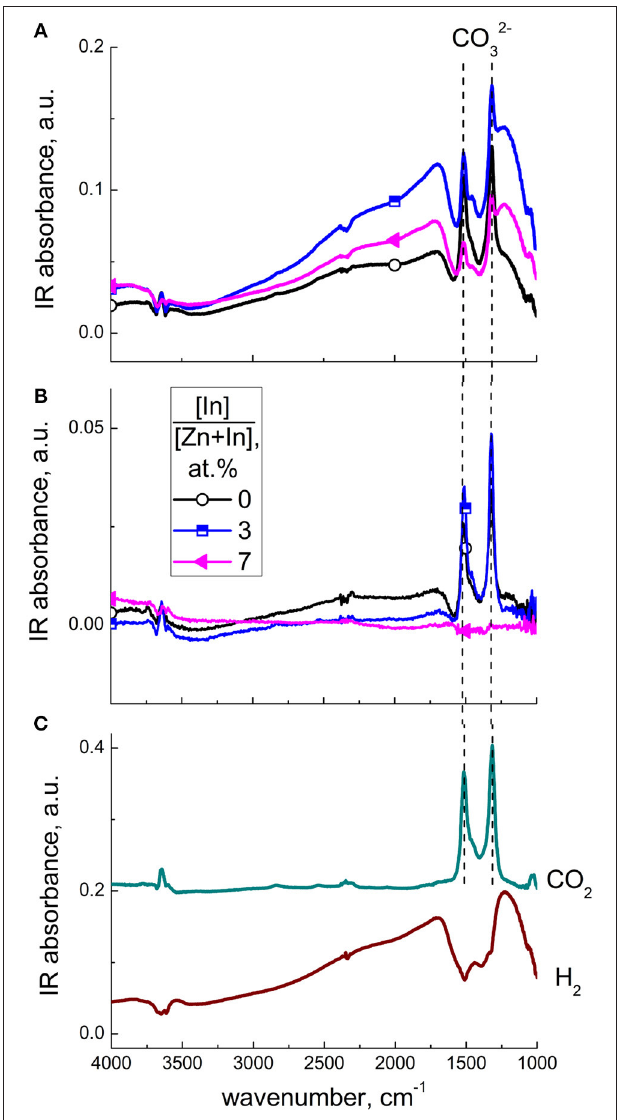
FIGURE 13 | DRIFT spectra of zinc oxide modified by different amounts of In 2 O 3 , exposed to 200 ppm CO at 450 ◦ C (A) and to air, 15 min after the end of CO exposure (B) . DRIFT spectra of ZnO(In, 3 at.%) exposed to 200 ppm H 2 and 0.1 % CO 2 at 450 ◦ C (C)